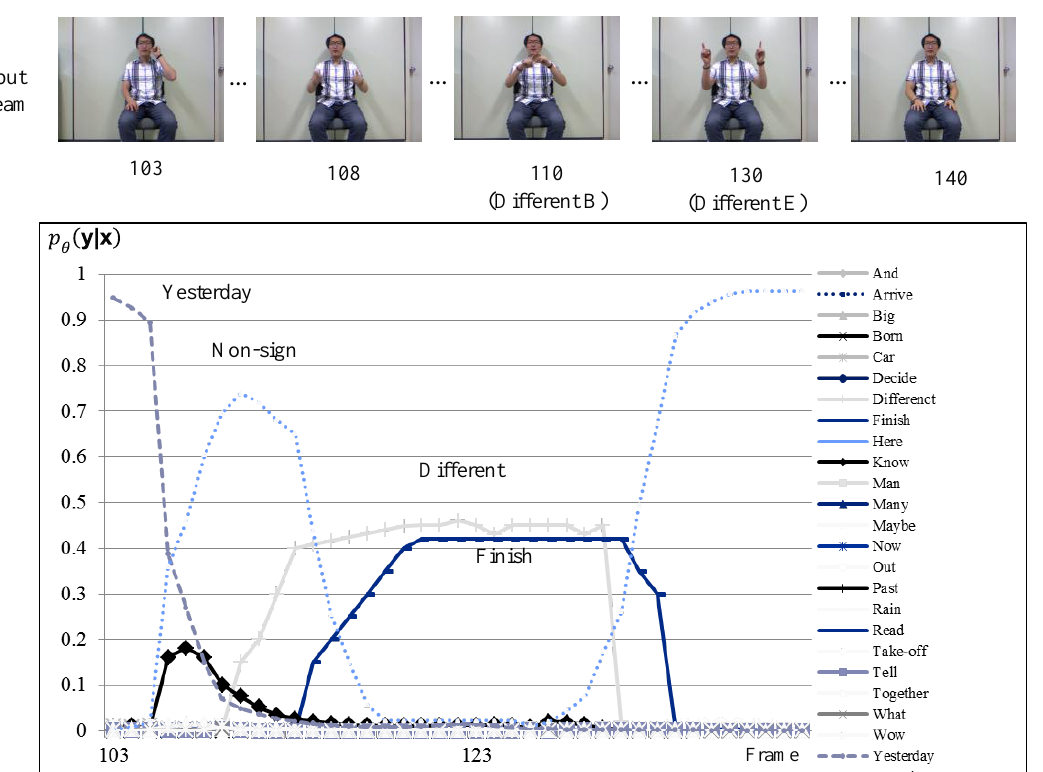
Figure 7. Sign language recognition result for H-CRF 𝟑𝑫 using a signed sentence.